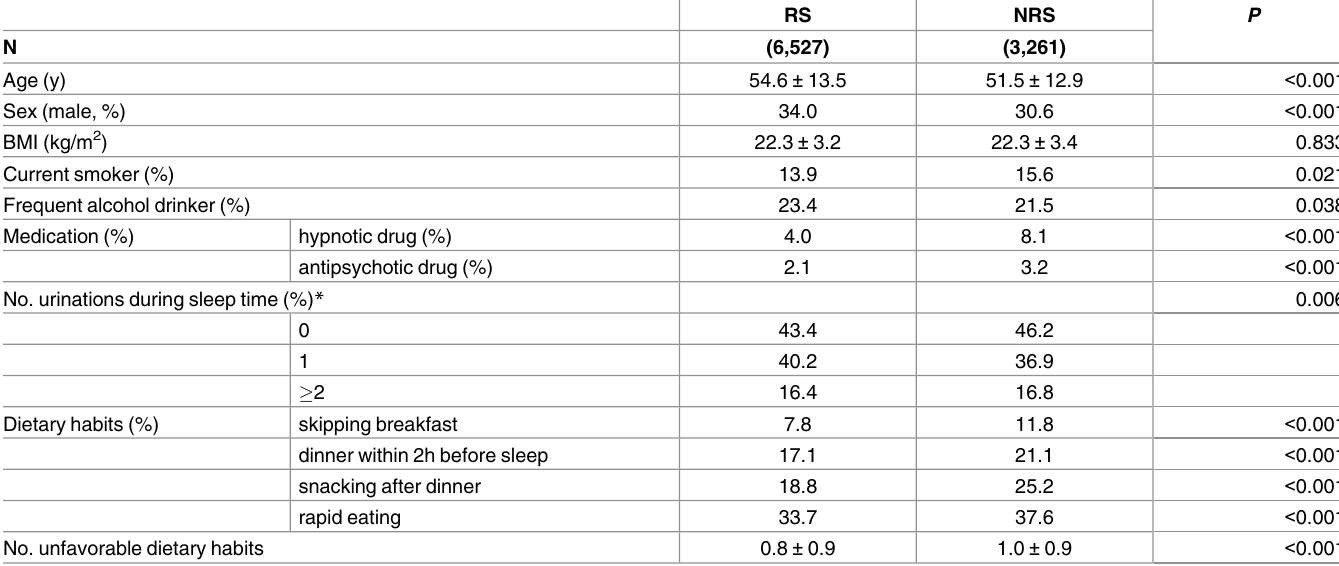
Table 2. Differencesin clinical and lifestyle factors between those with RS and NRS.